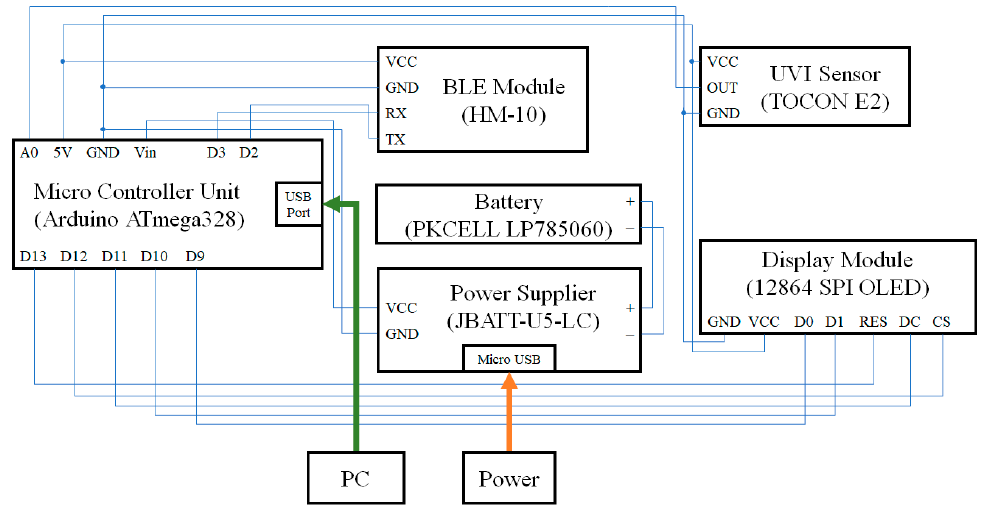
Figure 4. Circuit diagram of the portable measurement device. DC: Data/Command; CS: Chip Select.